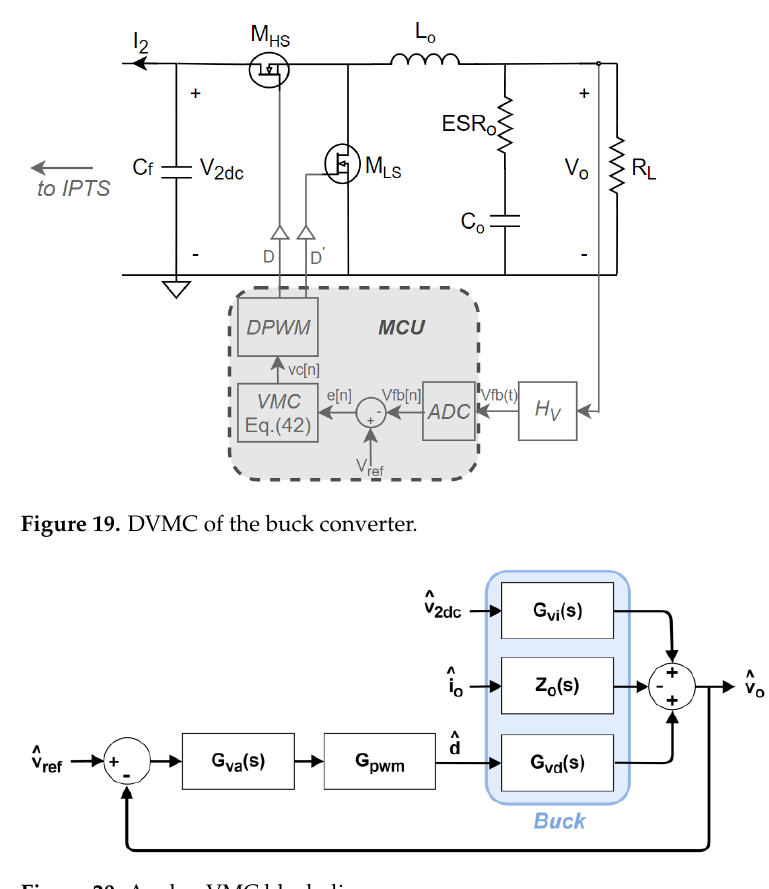
Figure 20. Analog VMC block diagram.